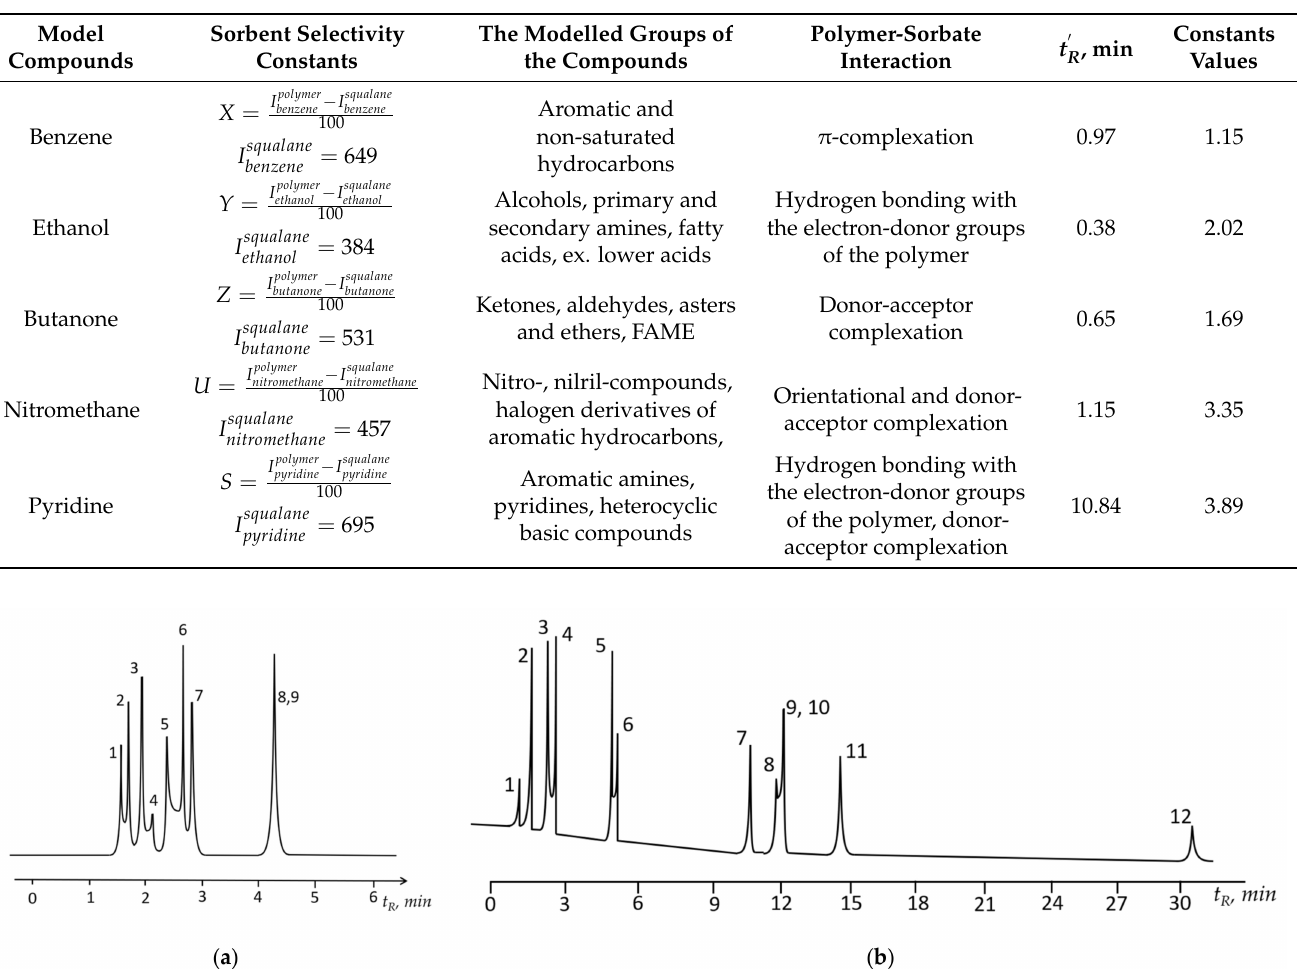
Table 5. Model sorbates of Rohrschneider model and their retention on PTBSN in the initial state.